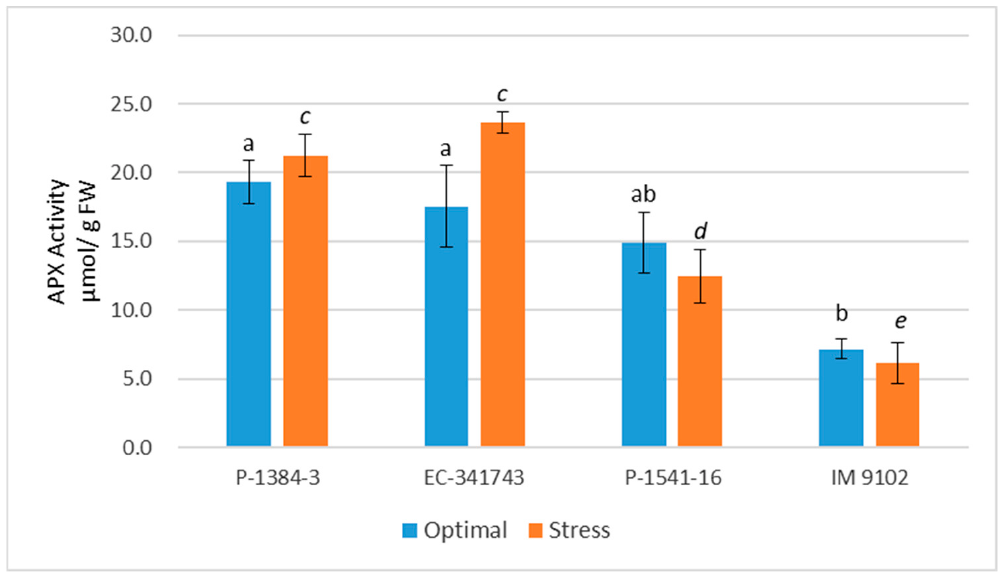
Figure 9. Ascorbate peroxidase enzyme activity of four field pea genotypes under optimal and heat stress. Columns with different letters indicate significant difference at p ≤ 0.05 (Fisher LSD test).